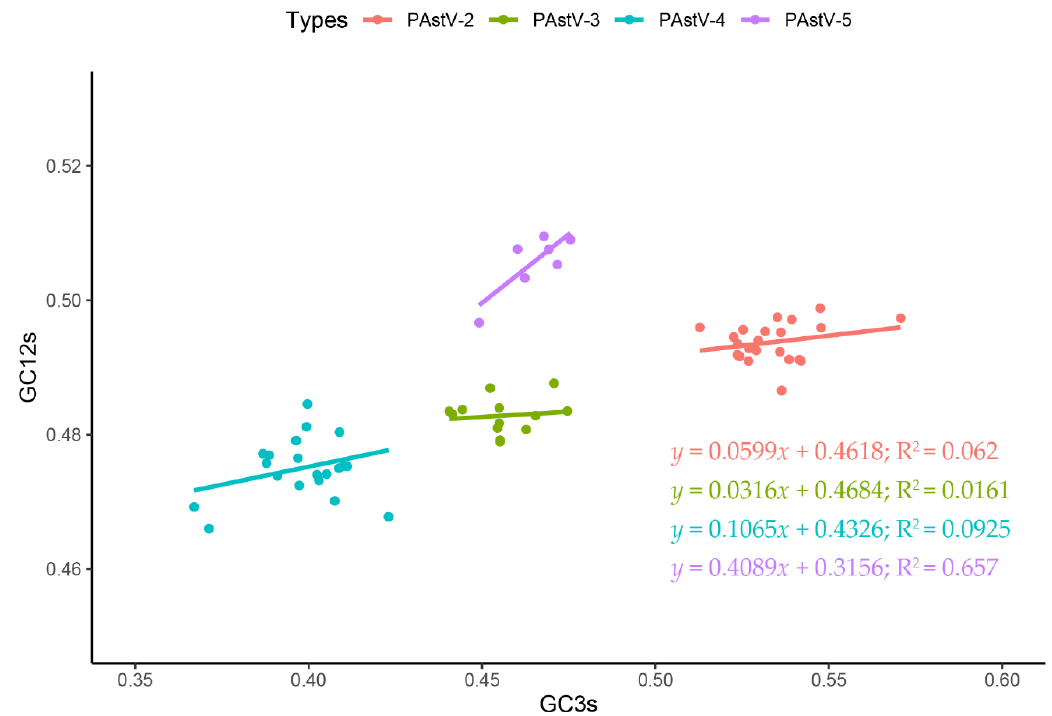
Figure 6. Neutrality analysis of the PAstV complete coding genomes. The neutrality plot displays the correlation between GC content at synonymous positions (GC12s) and GC content at non-synonymous positions (GC3s). PAstV-2, PAstV-3, PAstV-4, and PAstV-5 strains are represented in orange, green, blue, and purple, respectively.